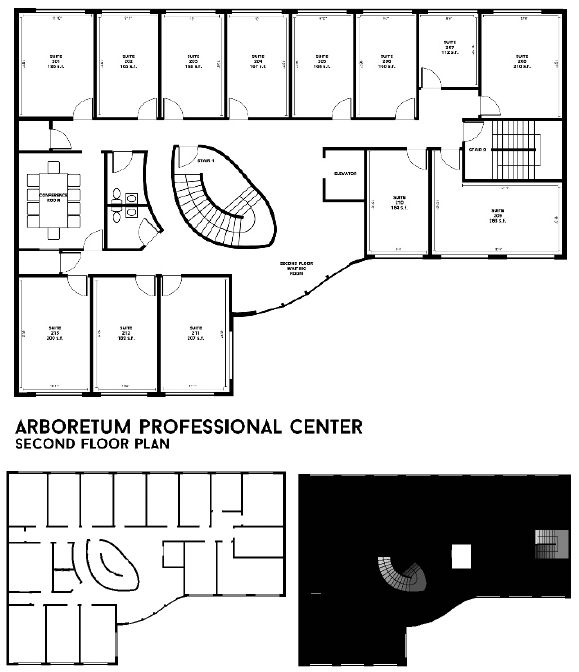
Fig. 7 Original floorplan (top) and edited versions for walls (bottom left), slab and stairways (bottom right)